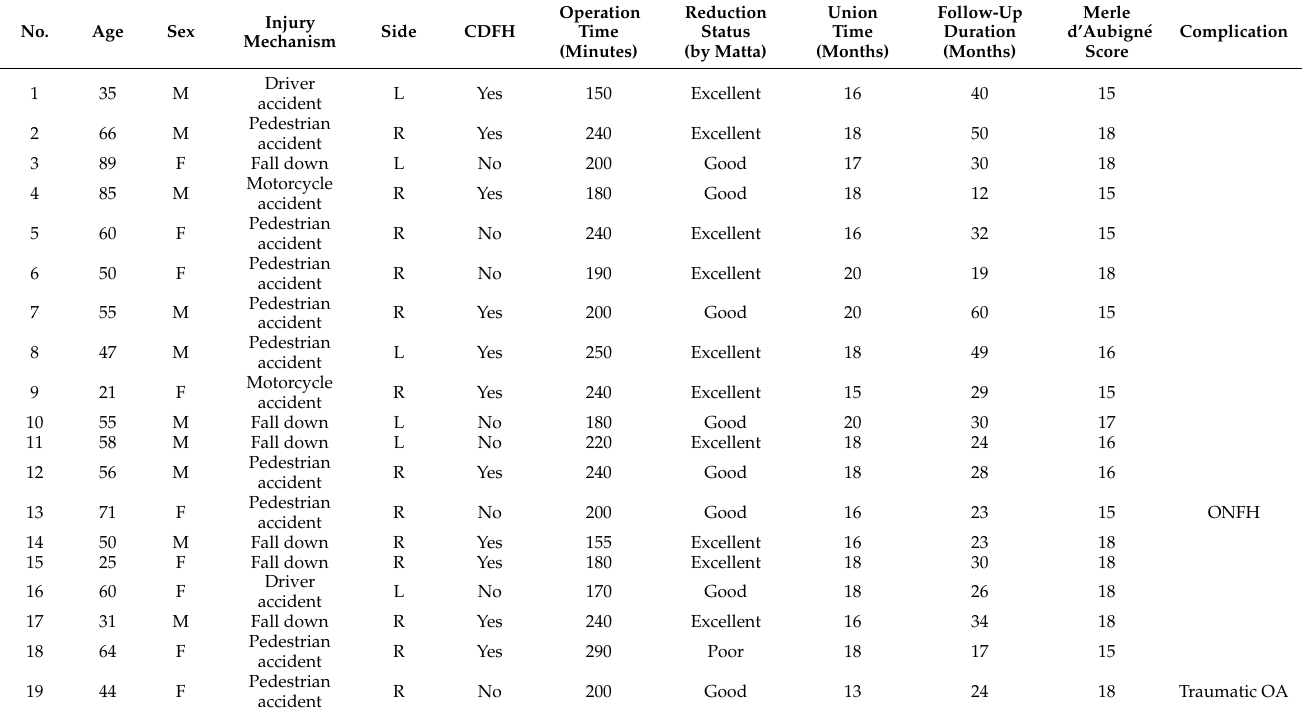
Table 1. Patient’s background and summarized